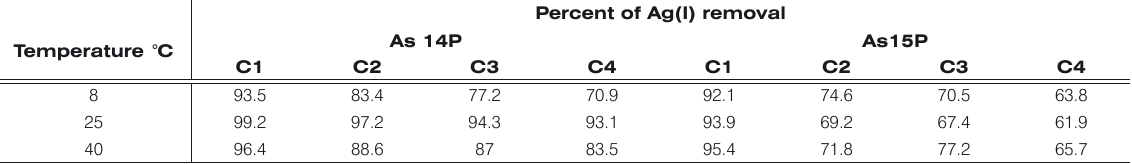
Table 2. Effect of temperature on removal percentage of Ag(I) using As 14P and As 15P (0.1 g resin, pH=4, C1=16 mg L -1 , C2=50 mg L -1, , C3=83 mg L -1 , C4=125 mg L -1 , 10 hours contact time).